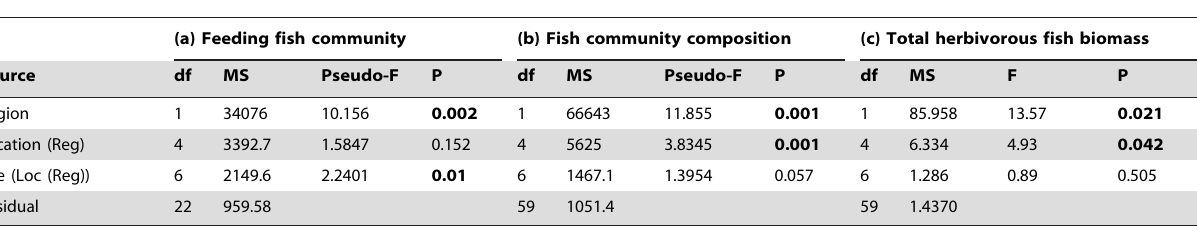
Table 1. Results of the three factor analyses of variance assessing differences between regions, locations and sites in (a) Mass standardised bite rates from the fish community feeding on the algal bioassays (PERMANOVA, data fourth-root transformed), (b) Roving herbivorous fish community composition (PERMANOVA, data fourth-root transformed) and (c) Total roving herbivorous fish biomass (ANOVA).